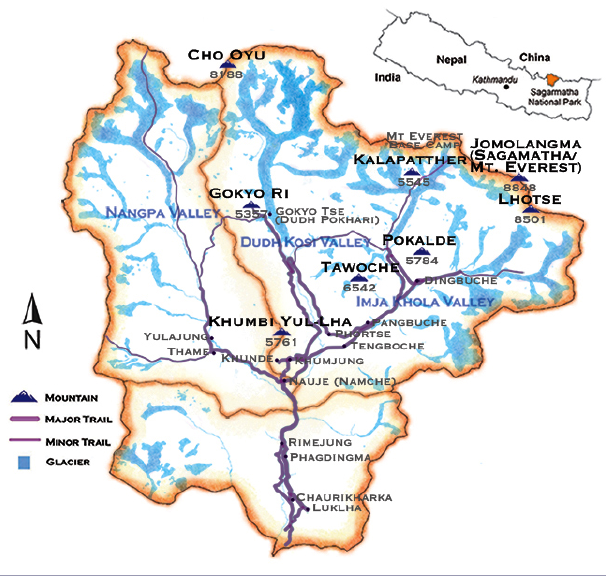
Fig. 1 . Sargamatha (Mount Everest) National Park and Buffer Zone, Nepal (locally known as Khumbu and Pharak). Tourist route is in the Imja Khola